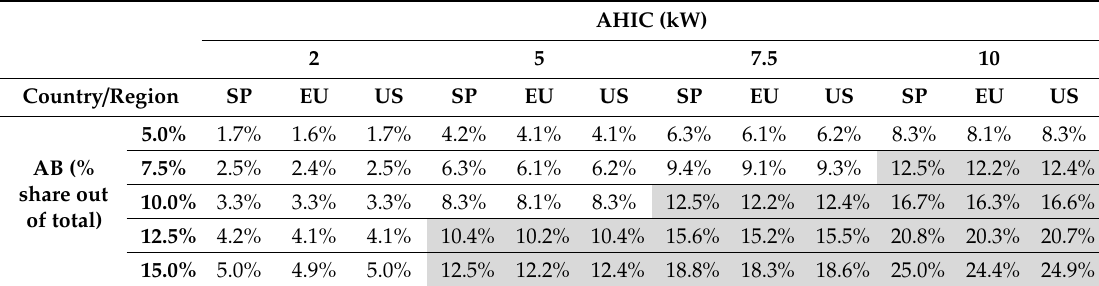
Table 3. Hourly aggregated demand